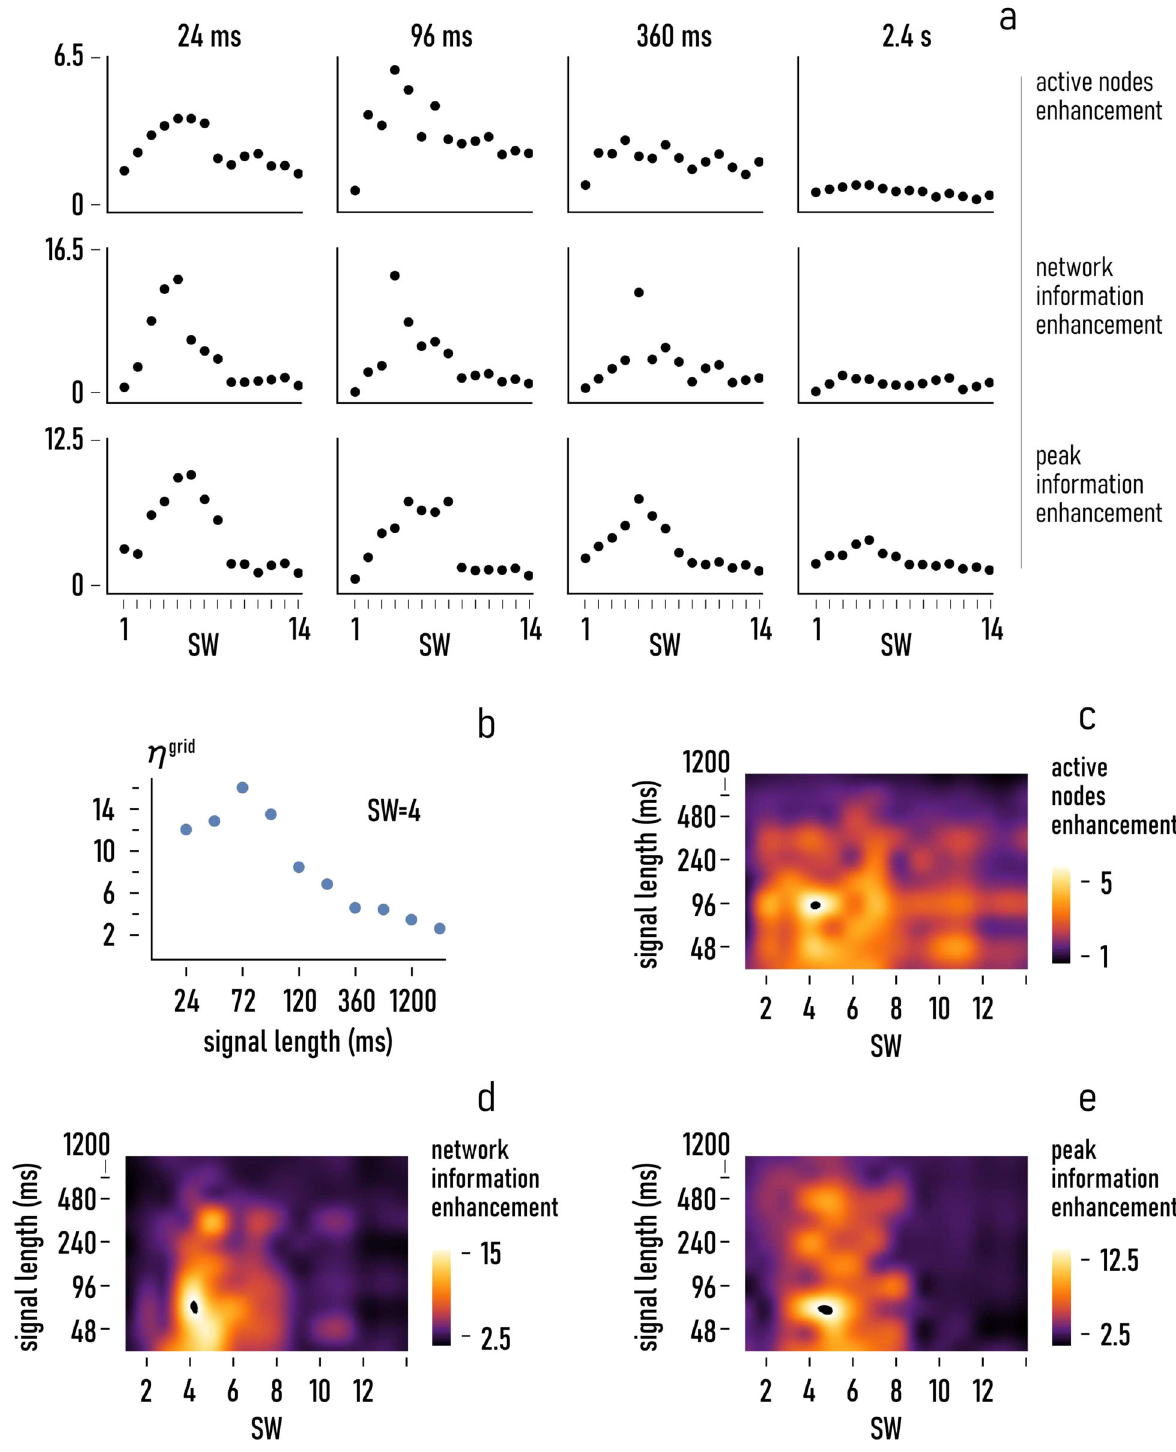
Fig. 3 Effect of signal length. Varying the length of the initial stimulus ( Δ t ) in discrete intervals, we observed the ef fi ciency of the networks ( η nodes , η grid , η peak ) exhibits different sensitivities to the small-world-coef fi cient ( a ). Speci fi cally, varying for a fi xed SW ¼ 4 4 t in the 24 – 2400 ms interval, we observe that η grid ranges from about 2 at 4 t ¼ 2400ms to about 12 for 4 t ¼ 72ms ( b ). Density plots of the network enhancement factors η nodes ( c ), η grid ( d ), η peak ( e ). In deriving the plots, we fi xed the value of frequency of the originating distubance as f ¼ 133Hz